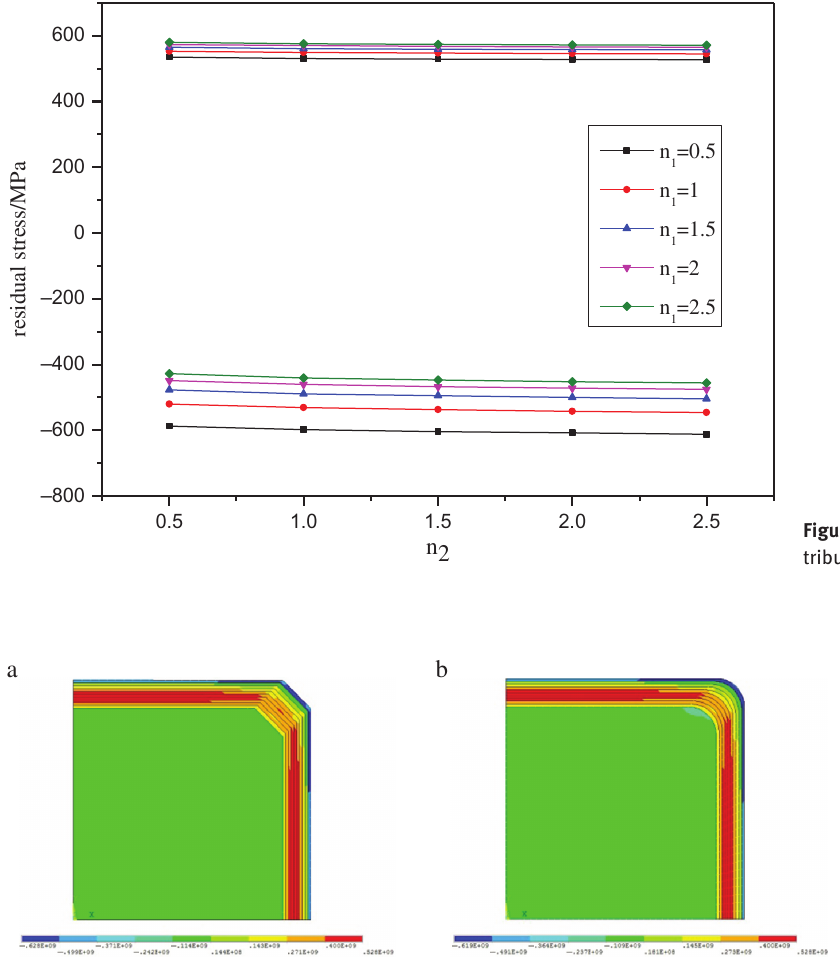
Figure 11: Residual stress distribution of different geometric shape (a) chamfered, (b)